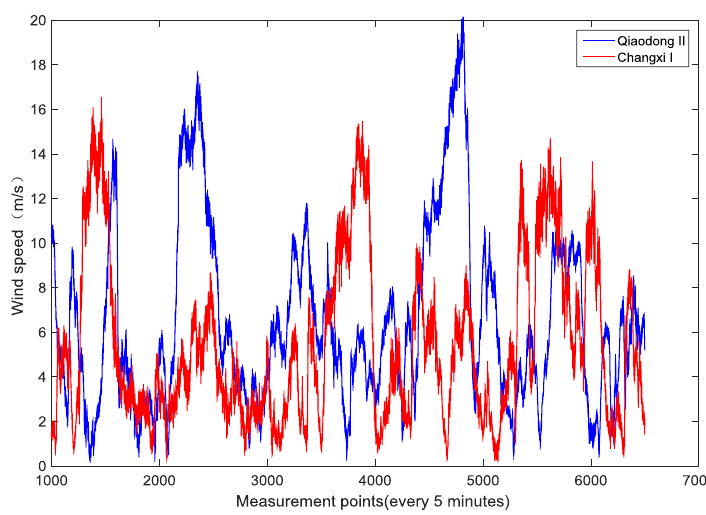
Figure 13. Wind speeds in time series of the Qiaodong II and Changxi I wind farms in a certain period.